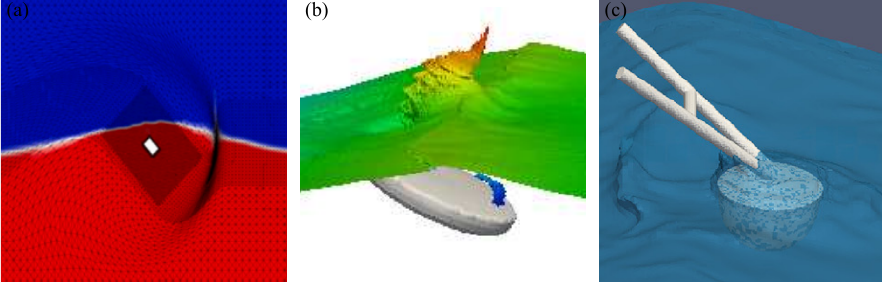
Figure 20. Extreme wave loads of the Seabased-like device [139], the CETO-like device [243] and the WaveStar-like devices [244], shown in ( a – c ),